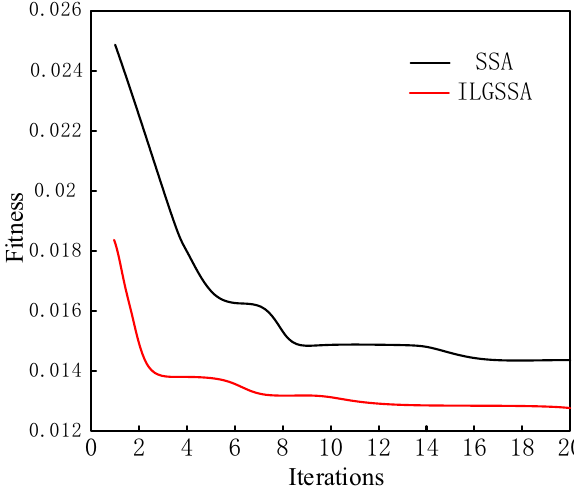
Figure 4. Comparison of fitness curves between ILGSSA and SSA.